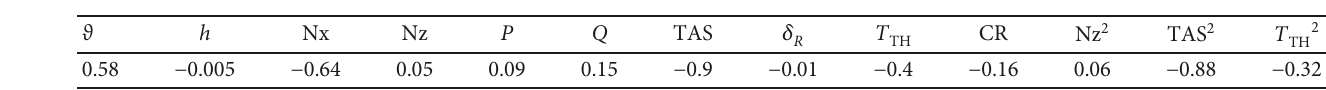
(b) Correlation between selected regressors and α